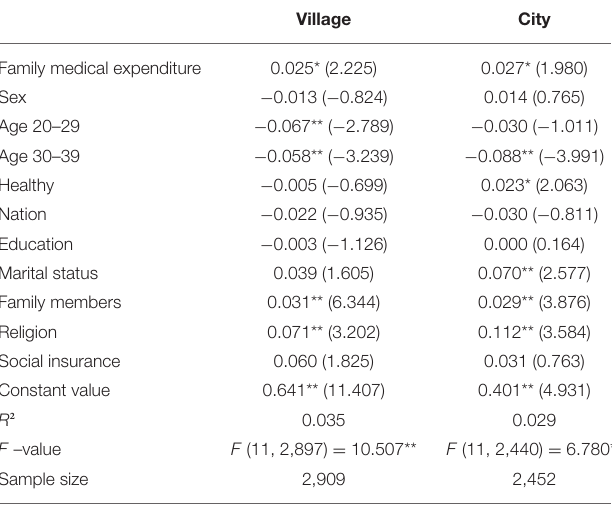
TABLE 7 | Sub–sample regression analysis